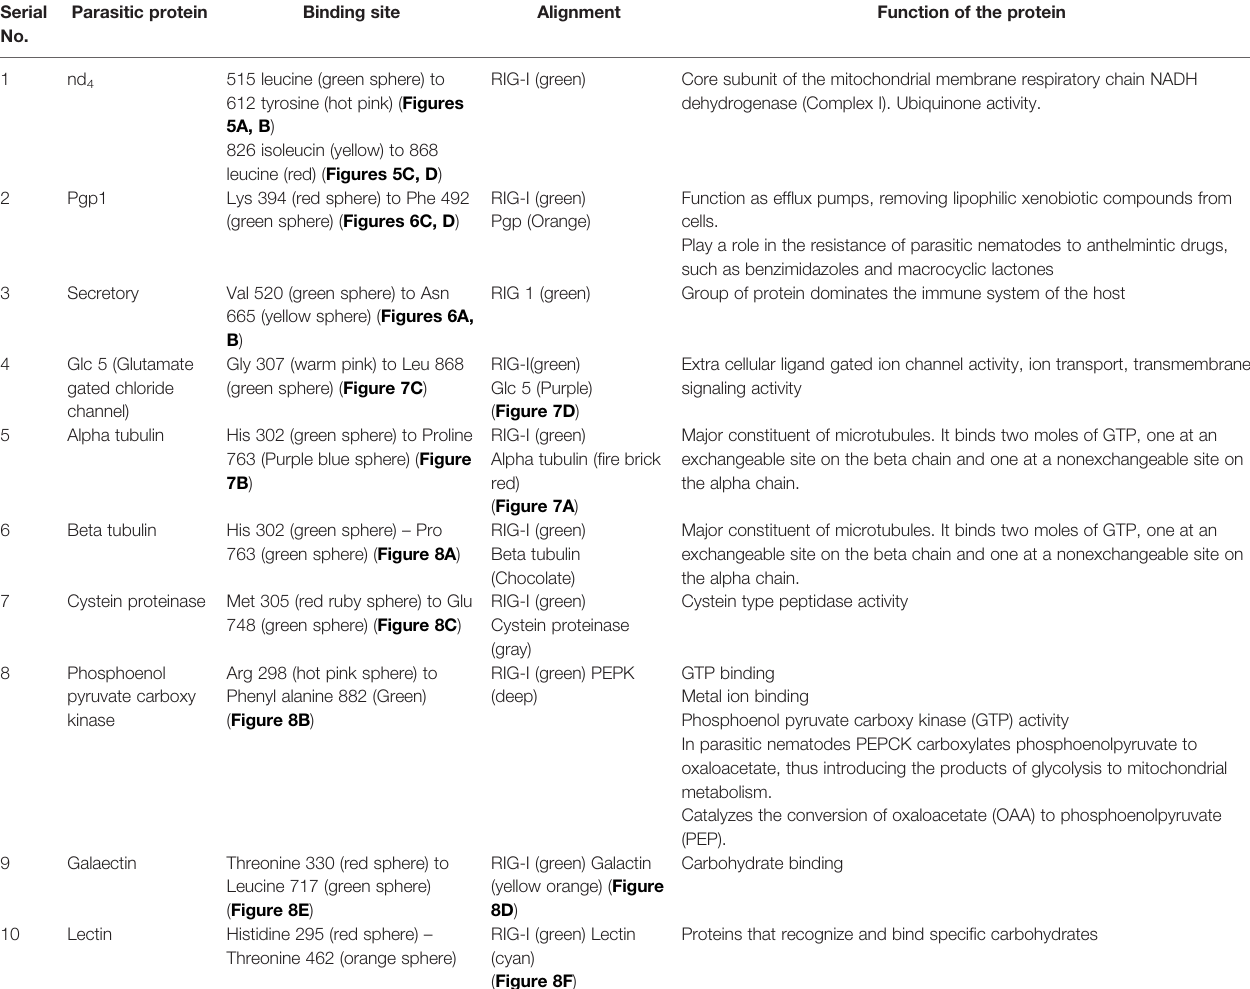
TABLE 5 | Molecular docking analysis of RIG-I with the protein of Haemonchus contortus . Serial No.